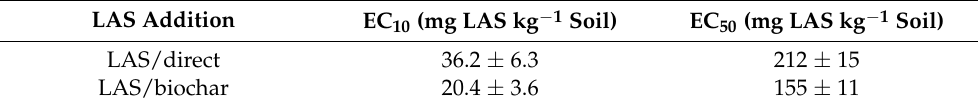
Figure 5. Acute dose-effects of linear alkylbenzene sulfonate (LAS) and LAS/biochar mixture to potential ammonia oxidation (PAO). LAS was added ( a ) directly to PAO buffer with soil (LAS/direct) or ( b ) to SB1 straw biochar, which was then added to PAO buffer with soil (LAS/biochar). Table 4. Effect concentrations (EC 10 and EC 50 ) for acute ecotoxicity of linear alkylbenzene sulfonate (LAS) to potential ammonia oxidation (PAO). LAS was added either directly to PAO buffer with soil (LAS/direct) or to SB1 straw biochar, which was then added to PAO buffer with soil (LAS/biochar). Data are model estimates ± standard error. Differences between treatments were significant at p <